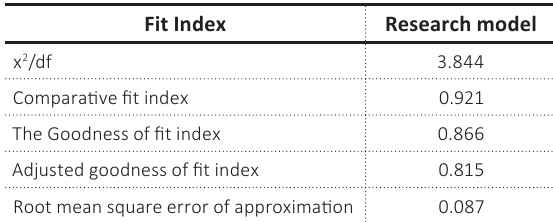
Table 4. Model fit indices